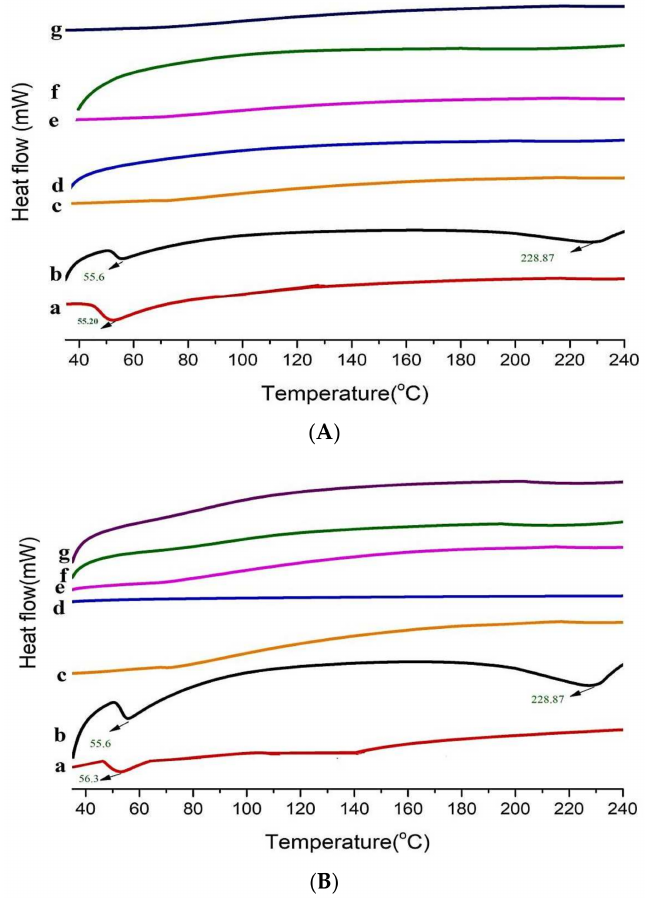
Figure 6. ( A ) DSC thermo-grams of (a) DEX, (b) PXM − 188, (c), 1:4 DEX:HP β CD (d) 1:4 DEX:HP β CD:PXM − 188 2.5%, (e) 1:4 DEX:HP β CD:PXM-188 5.0%, (f) 1:4 DEX:HP β CD:PXM −